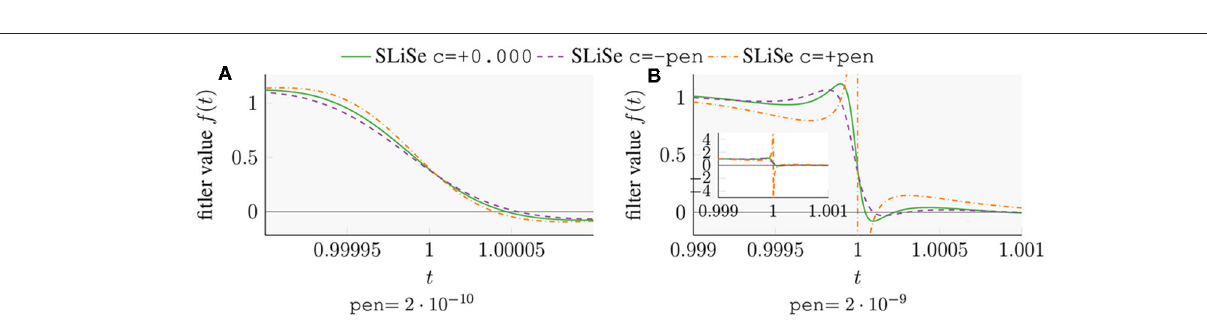
on the parameters: TABLE 2 | Residual levels and steepness of the filter functions shown in